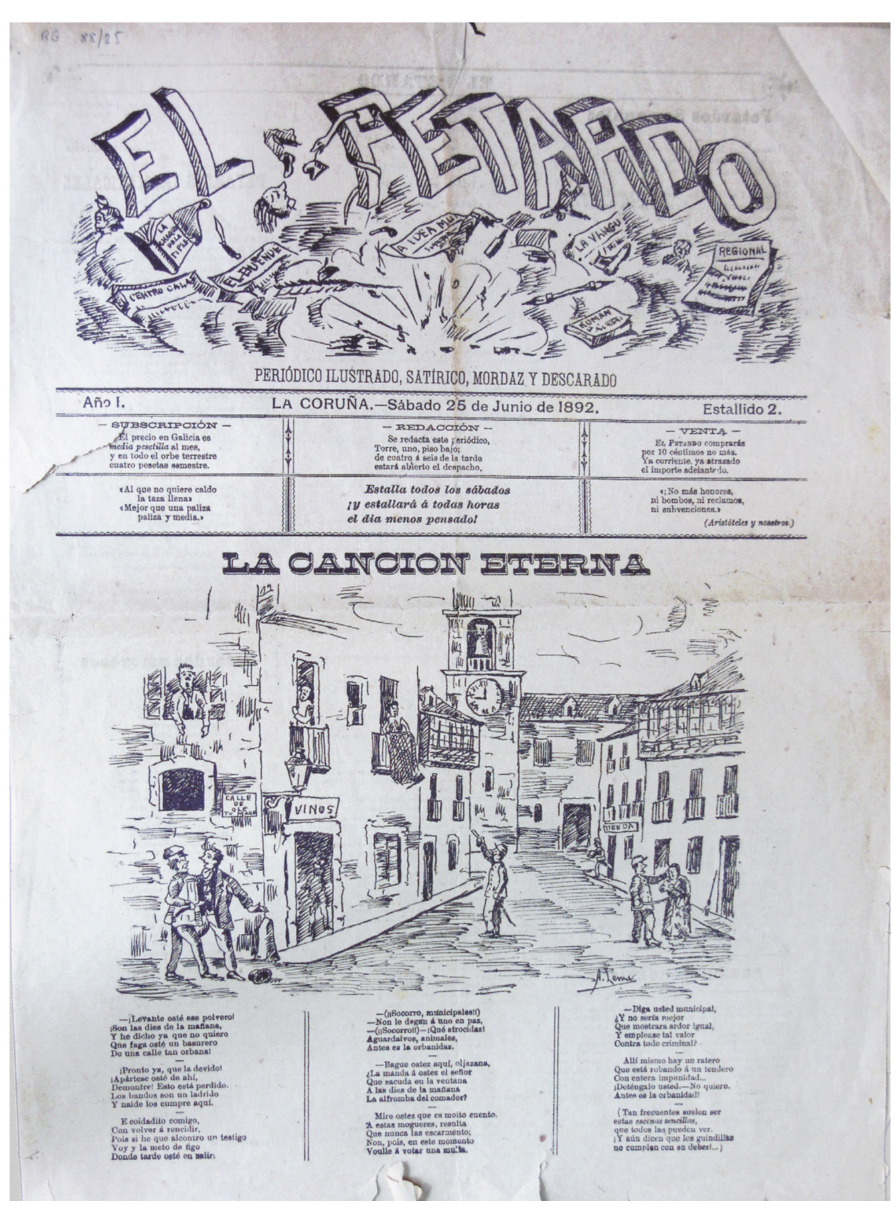
Figure 3. El Petardo , 25 July 1892. Printed magazine. 40.5 × 30 cm, Real Academia Gallega, A Coruña.